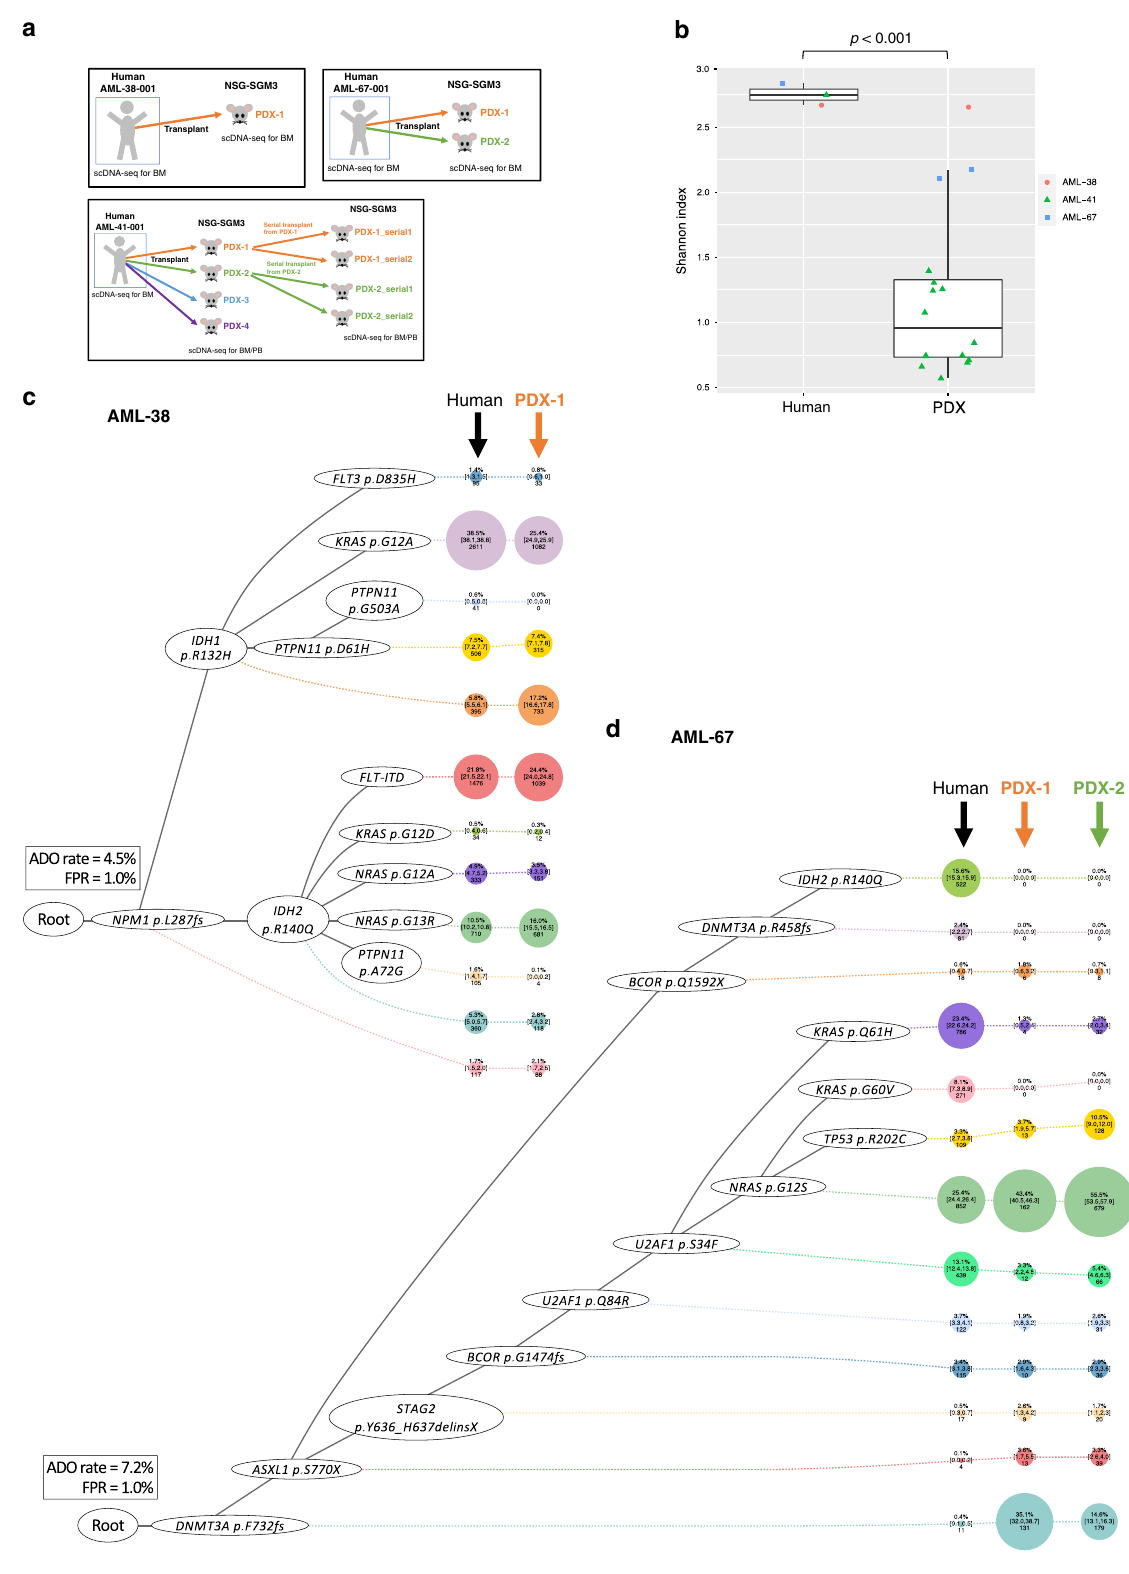
Variant detection by single-cell DNA sequencing . We used a micro fl uidic approach with molecular barcode technology to amplify the DNA from individual cells. Brie fl y, cryopreserved BMMCs were thawed, and cells were quanti fi ed using a Countess Automated Cell Counter (Thermo Fisher Scienti fi c). The cells were resuspended in cell buffer and diluted to a concentration of 2,000,000 – 4,000,000